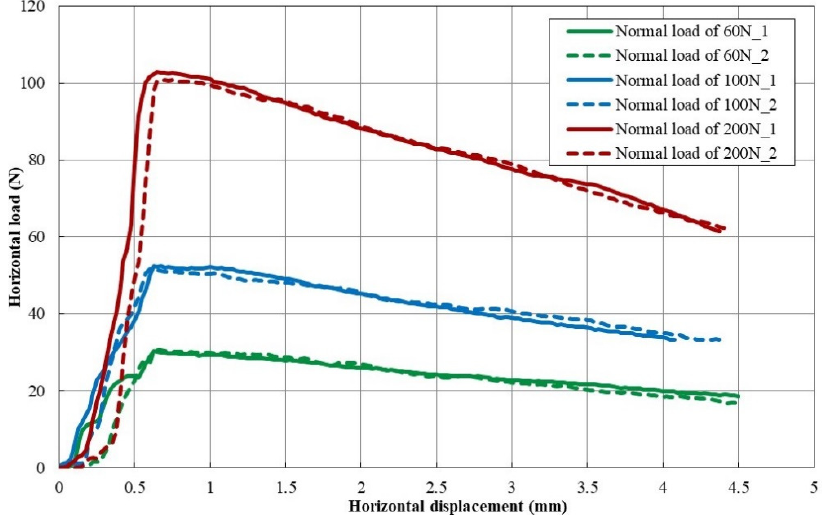
Figure 5. Measured horizontal load versus horizontal displacement for two groups of tests (under normal loads of 60, 100, and 200 N).